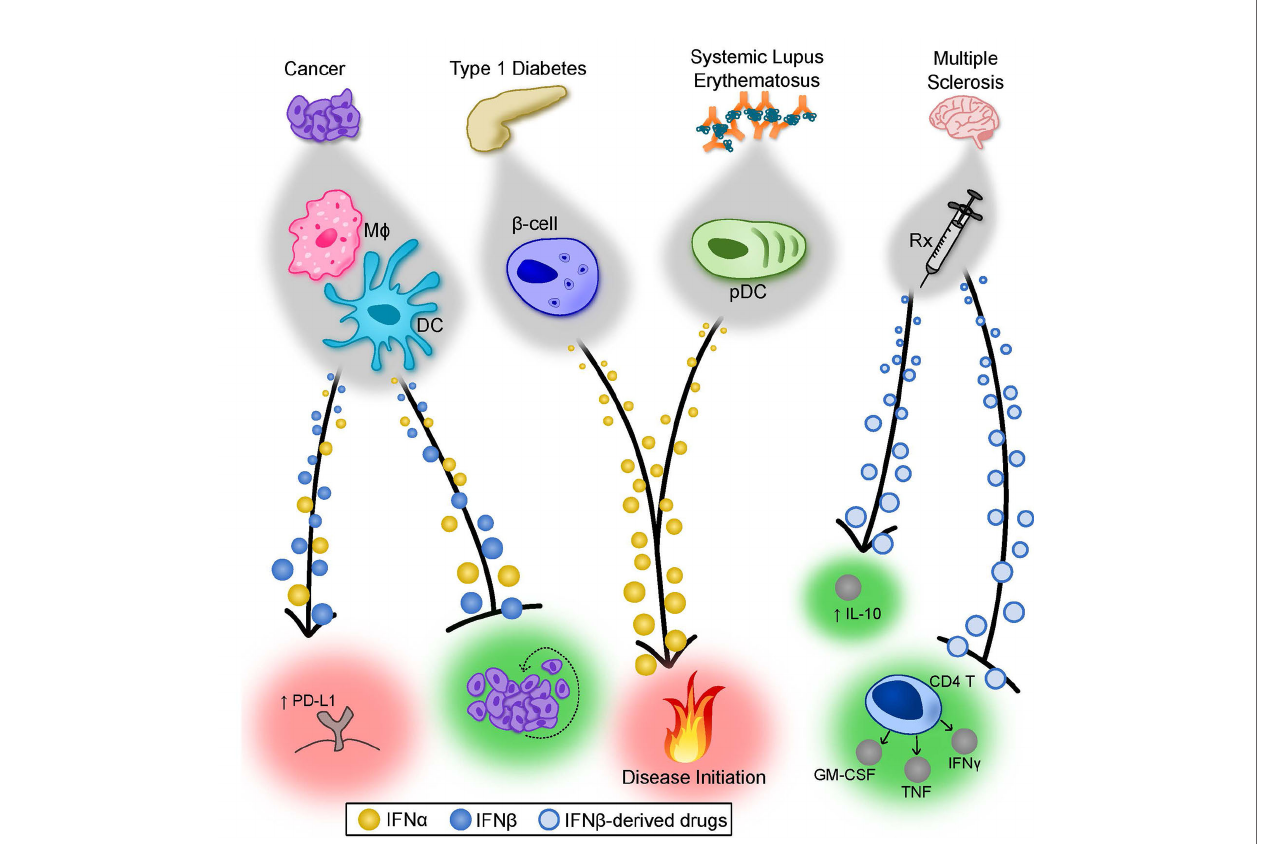
FIGURE 2 | Summary of the Properties of IFN a and IFN b in cancer and autoimmunity. Type I IFNs display both unique and overlapping properties in various disease states. In cancer, depending on the tumor and degree of metastases, both IFN a and IFN b can contribute to tumor rejection by directly limiting tumor cell proliferation (depicted) but also through modulation of antitumor immune responses (not depicted). In certain cases, type I IFNs can induce PD-L1 expression on tumor cells, suppressing immune-mediated killing of the tumor. The factors that cause type I IFNs to exert detrimental effects remain poorly understood. In T1D, there is evidence that IFN a subtypes play an important role in pathogenesis. Forced expression of IFN a by pancreatic b -cells accelerated the onset and severity of T1D in a mouse model, and patients receiving IFN a therapy for treatment of other diseases have a higher incidence of T1D. Similarly, immune complex-driven activation of pDCs induces robust IFN a production, which may participate in initiation of SLE. Finally, IFN b -derived therapeutics have well-established ef fi cacy for treating MS patients. Though still largely debated, the mechanism of protection mediated by IFN b is complex and possibly includes limiting cytokine production from pathogenic CD4 + T cells and augmenting IL-10 production in a number of cell types. b -cell, pancreatic b -cell; DC, dendritic cell; IL, interleukin; M j , macrophage; MS, multiple sclerosis; pDC, plasmacytoid dendritic cell; Rx, prescription drug; SLE, systemic lupus erythematosus; T1D, type I